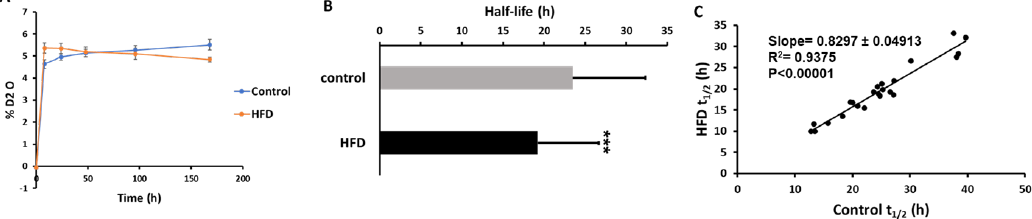
Figure 3. Effect of an HFD on plasma HDL proteome dynamics. A , Total body water enrichment. The mice were given a bolus load of heavy water (30 μL/g body weight) and followed by maintenance of 8% (v/v) heavy water in drinking water for seven days which resulted in a steady-state body water enrichment of ~5%. B , Comparison of average half-lives of HDL proteins in the control and HFD groups. Results are mean ± SD; n = 6–7/group. Statistical significance, *** indicates p < 0.005 compared to control. C , The relationships between the half-lives of individual proteins in HFD mice as a function of these values in control mice.